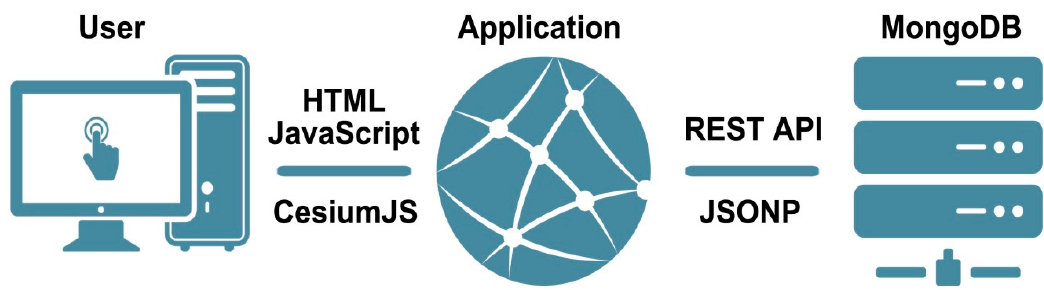
Figure 1. Architecture of the 3D cadastral system based on the MongoDB database and Cesium library.